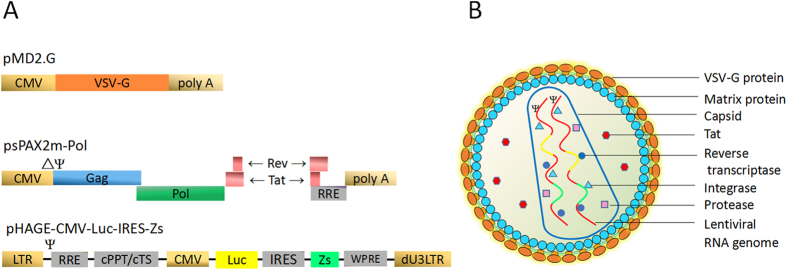
Generation of patient’s HIV-1 derived lentiviral particles with dual reporters.(A) A mixture of packaging plasmid psPAX2m-Pol, envelop plasmid pMD2.G and transfer plasmid pHAGE-CMV-Luc-IRES-ZsGreen were co-transfected into 293FT cells. CMV, Cytomegalovirus Promoter; VSV-G, Vesicular Stomatitis Virus G protein; Ψ, packaging signal of lentivirus; ΔΨ, packaging signal deleted; Gag, gag polyprotein that the processed proteins includes matrix protein and capsid; Pol, pol polyprotein that the processed proteins includes protease, integrase and reverse transcriptase; Tat, tat protein; Rev, rev protein; RRE, the Rev response element which allows for Rev-dependent mRNA export from the nucleus to cytoplasm; 5′-LTR, 5′ long terminal repeat; cPPT/cTS, central polypurine tract and central termination sequence; Luc, luciferase from pGL-3 promoter vector; IRES, internal ribosome entry site; Zs, ZsGreen protein; WPRE, woodchuck posttranscriptional regulatory element; dU3LTR, self-inactivating 3′ long terminal repeat. (B) Structure of lentiviral particles produced by co-transfection of three plasmids into 293FT cells.